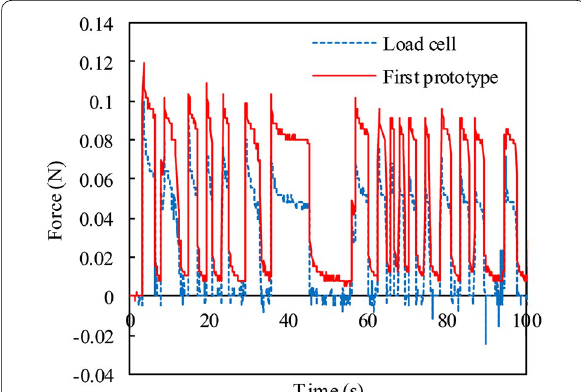
Fig. 7 Comparison of two forces measured by first prototype sensor and load cell when a random force was applied ( T > T g ). Substituting the strain measured by the prototype sensor into the linear approxi- mation formula in Fig. 5, we calculated the applied force